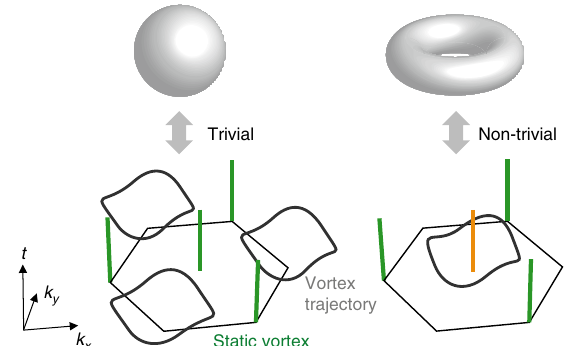
Fig. 2 Experimental realization of topological bands in driven optical lattices. a Three laser beams (red arrows) interfere under 120° and form a hexagonal optical lattice. The geometry can be tuned via the polarisation of the lattice beams using two wave plates (gray lines). The lattice can be accelerated along a circular trajectory by modulating the phases of the lattice laser beams. b Illustration of the tight-binding model of the bare lattice (left) and the effective Hamiltonian for the driven lattice (right). The renormalized tunnel elements arise from a shaking frequency ω and shaking amplitude α . The sublattice offset in the effective Hamiltonian can be tuned via the shaking detuning